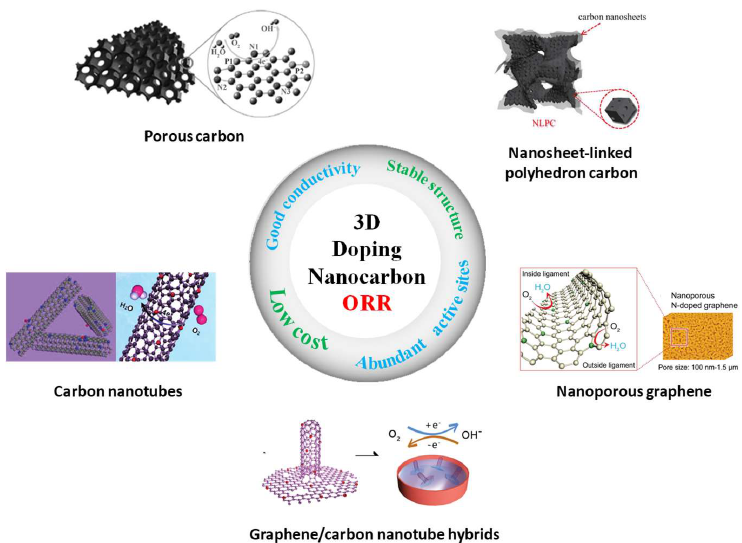
Figure 4. Advantages of metal-free 3D doped-nanocarbon materials and their applications as high- efficiency ORR